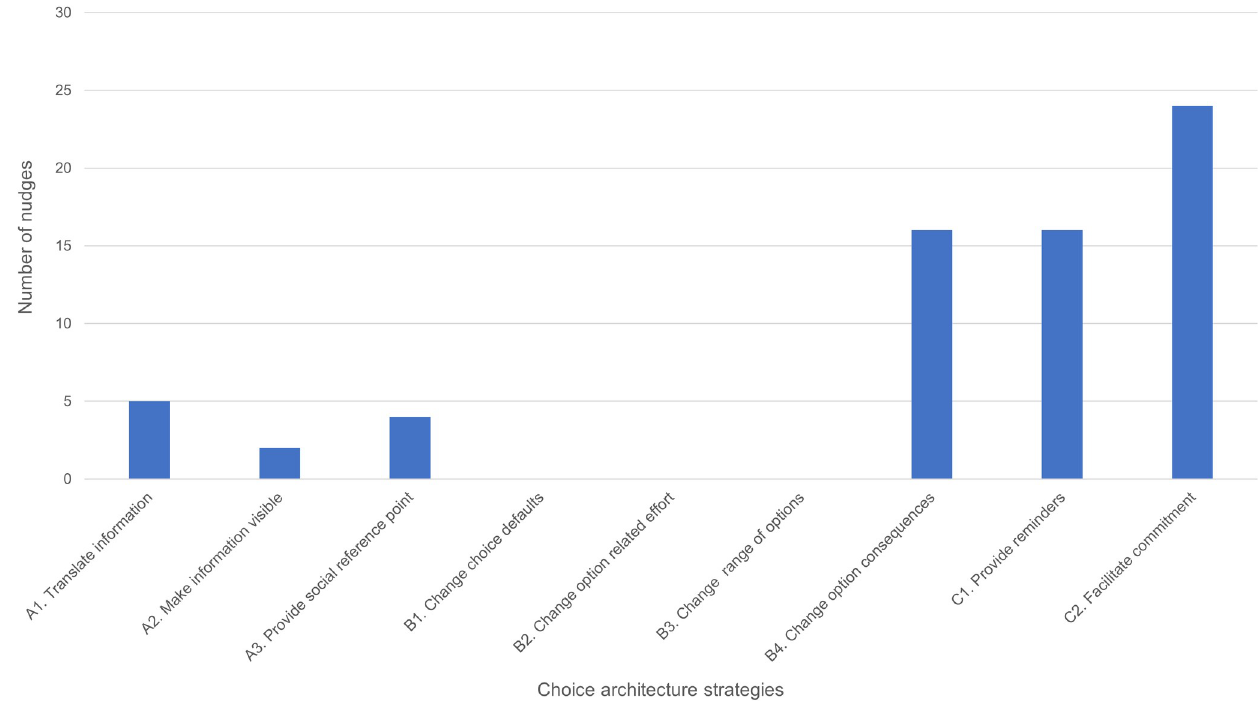
Fig 3. Number of identified nudge strategies in selected studies based on the three choice architecture categories A. Decision information, B. Decision structure, and C. Decision assistance (Mu¨nscher et al. 2016). A1 Translate information; A2 Make information visible; A3 Provide social reference point; B1 Change choice defaults; B2 Change option related effort; B3 Change range or composition of options; B4 Change option consequences; C1 Provide reminders; C2 Facilitate